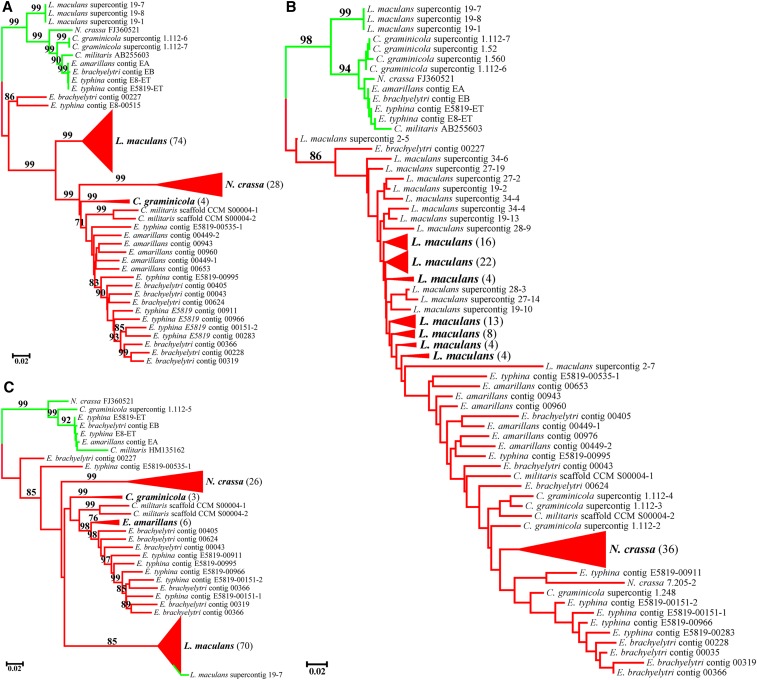
Cladogram of the (A) 18S, (B) 5.8S, and (C) 28S rDNA paralogs from seven fungal species examined in this study using NJ analyses. Blue and red branches indicate functional genes and pseudogenes, respectively. Numbers in brackets are rDNA sequences included in each compressed clade. Bootstrap support values that were <70% were not shown.